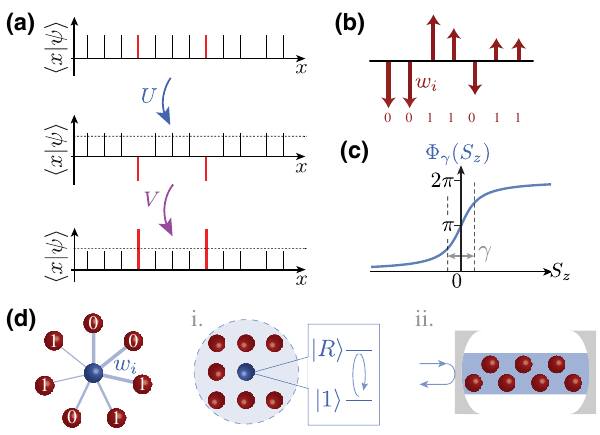
FIG. 1. (a) Sketch of Grover’s algorithm, showing the ampli- tude of each basis state | x (cid:3) in the system state | ψ (cid:3) . One iteration consists of the oracle U marking the solution states (red) with a π phase shift, followed by inversion about the average V . (b) Num- ber partitioning: a set of weighted spins is partitioned, if possible, into two sets of equal total weight. (c) Phase shift (cid:4) γ ( S z ) applied by generalized oracle with step width γ . (d) The weights w i are encoded by couplings of system spins (red) to an ancilla (blue), which can be either (i) a central spin (e.g., Rydberg atom); or (ii) a bosonic mode (e.g.,